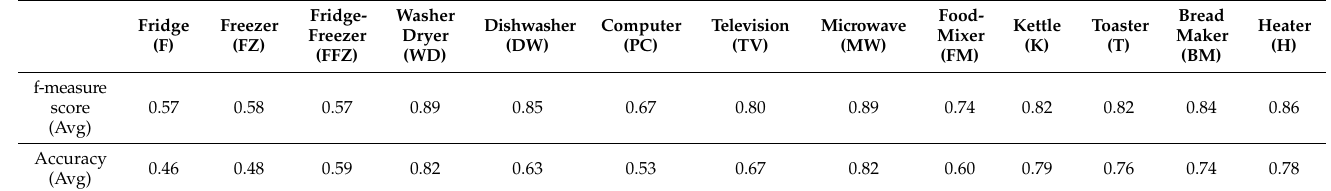
Table 2. Performance of SC-M algorithm applied on the REFIT